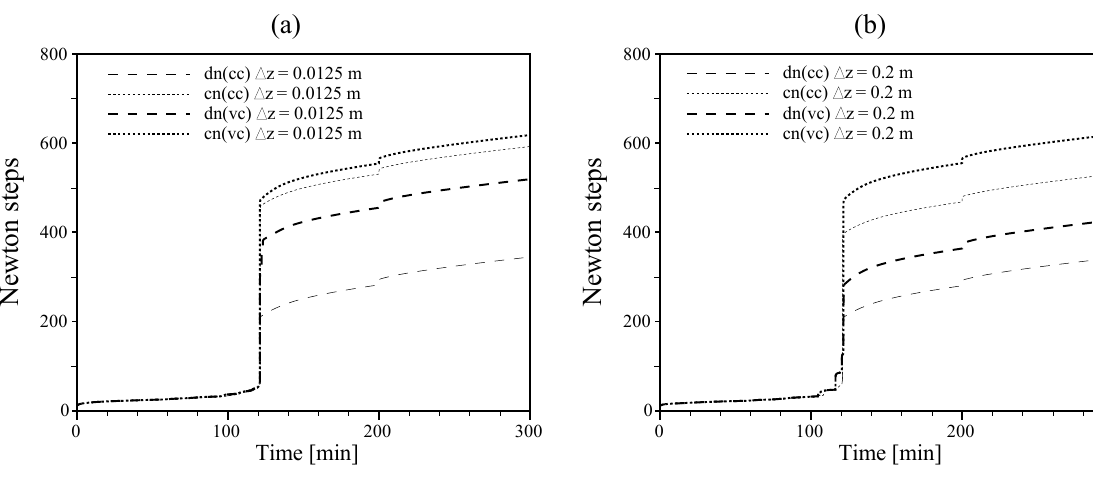
Figure 3. Number of Newton steps for excess saturation on a hillslope (first scenario) using different vertical discretizations.